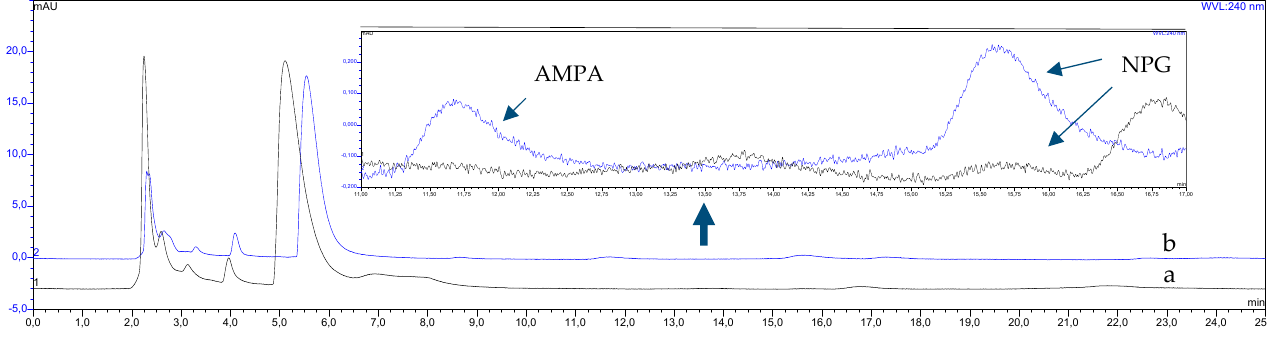
Figure 4. Chromatograms obtained from the analysis of UAE—SLM extracts of rice flour samples: ( a )—blank sample and ( b )—fortified extract (SLM conditions—donor: 100 mL of extract at pH = 11; acceptor: 5 mL 2 M NaCl ; membrane phase: 20% Aliquat 336 in DHE; flow rate of donor and